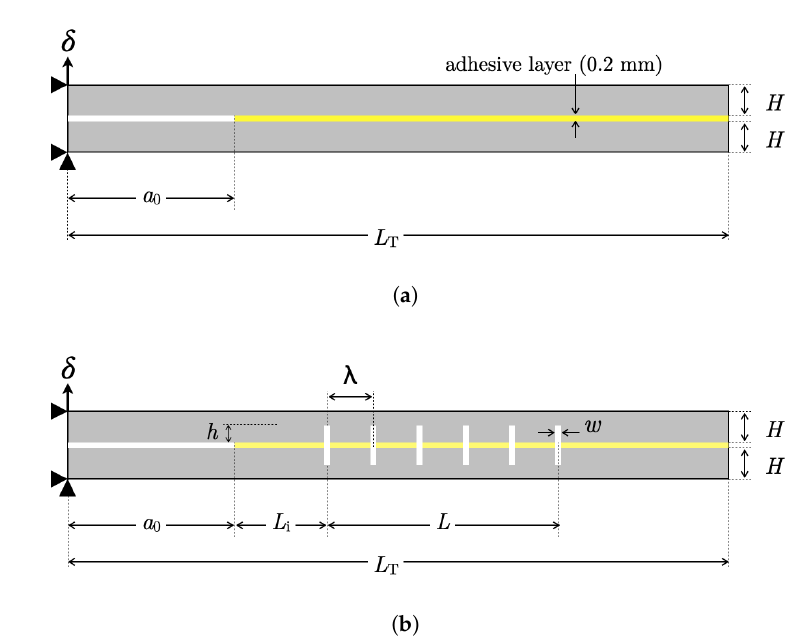
Figure 2. Schematic of the ( a ) baseline and ( b ) notched DCB